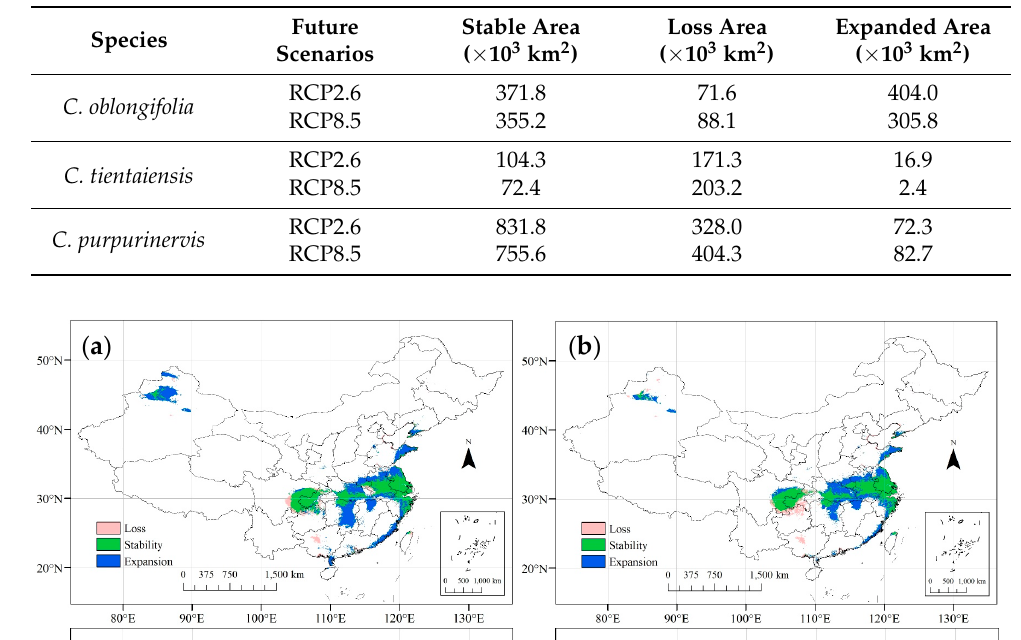
Table 4. Predicted changes in the climatically suitable habitats area (km 2 ) of three Carpinus species under different climate change scenarios (RCP2.6 and RCP8.5 in the years 2041–2060).